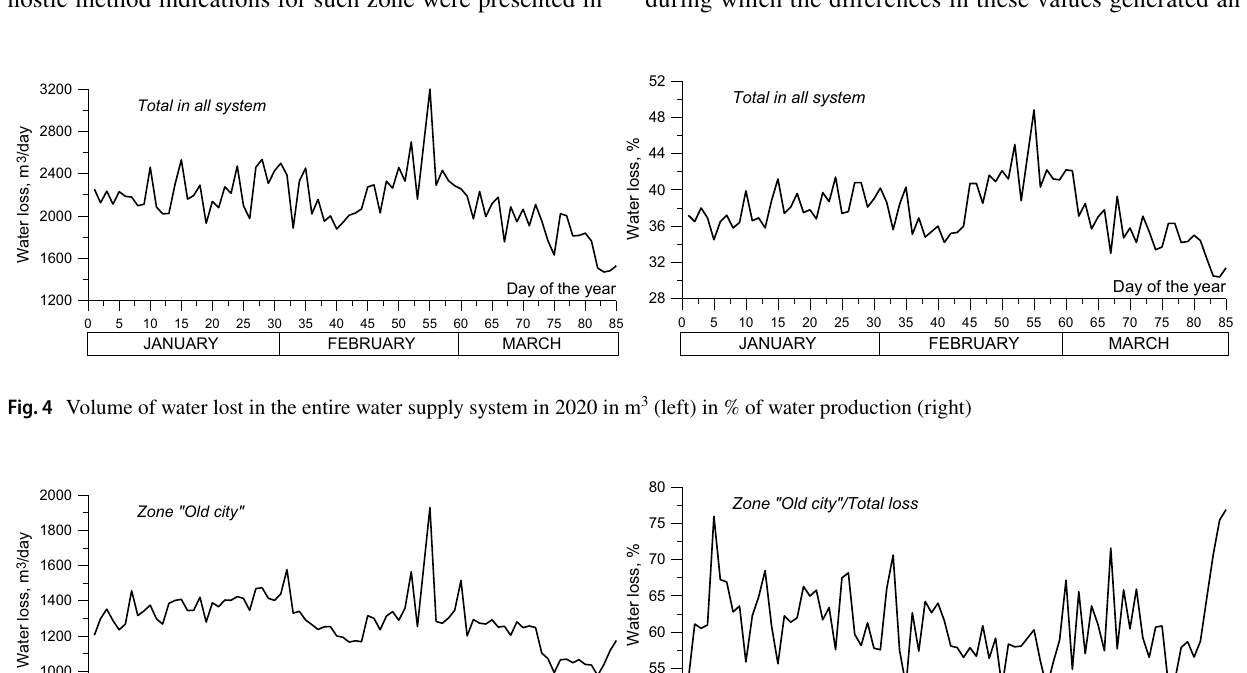
Z/T ) in relation to the losses in the entire water supply system (right)